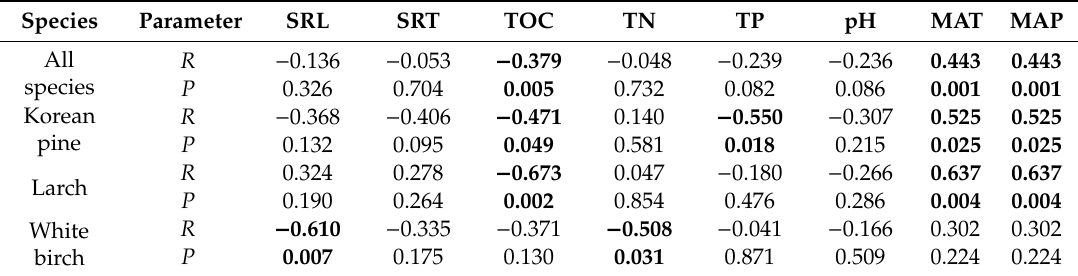
Table 4. The matrix of correlation coefficients (Person) and p value between root exudation rates and root morphological traits and environmental factors. Correlations with a P values below 0.05 are in bold.